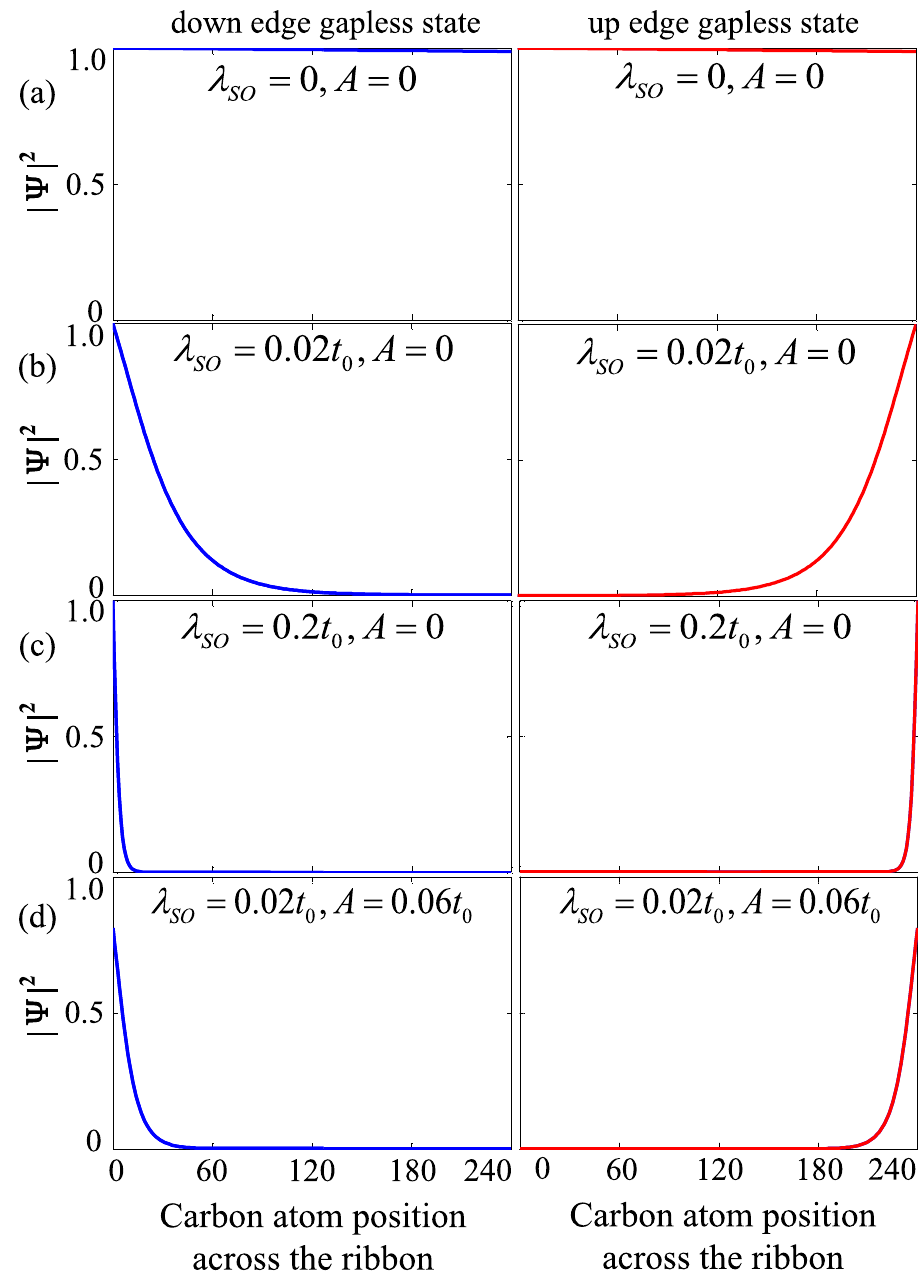
Figure 2. Probability density across the single layer armchair GNR of the edge states in the presence of different and A = 0 ( a ), λ = 0 and A = 0 ( b ), λ = . t 0 2 and A = 0 ( c ), and λ = . t 0 02 intrinsic SOC and strain λ = 0 so so so 0 so 0 and = . A t 0 06 ( d ). The GNR width is set to be 240 carbon 0